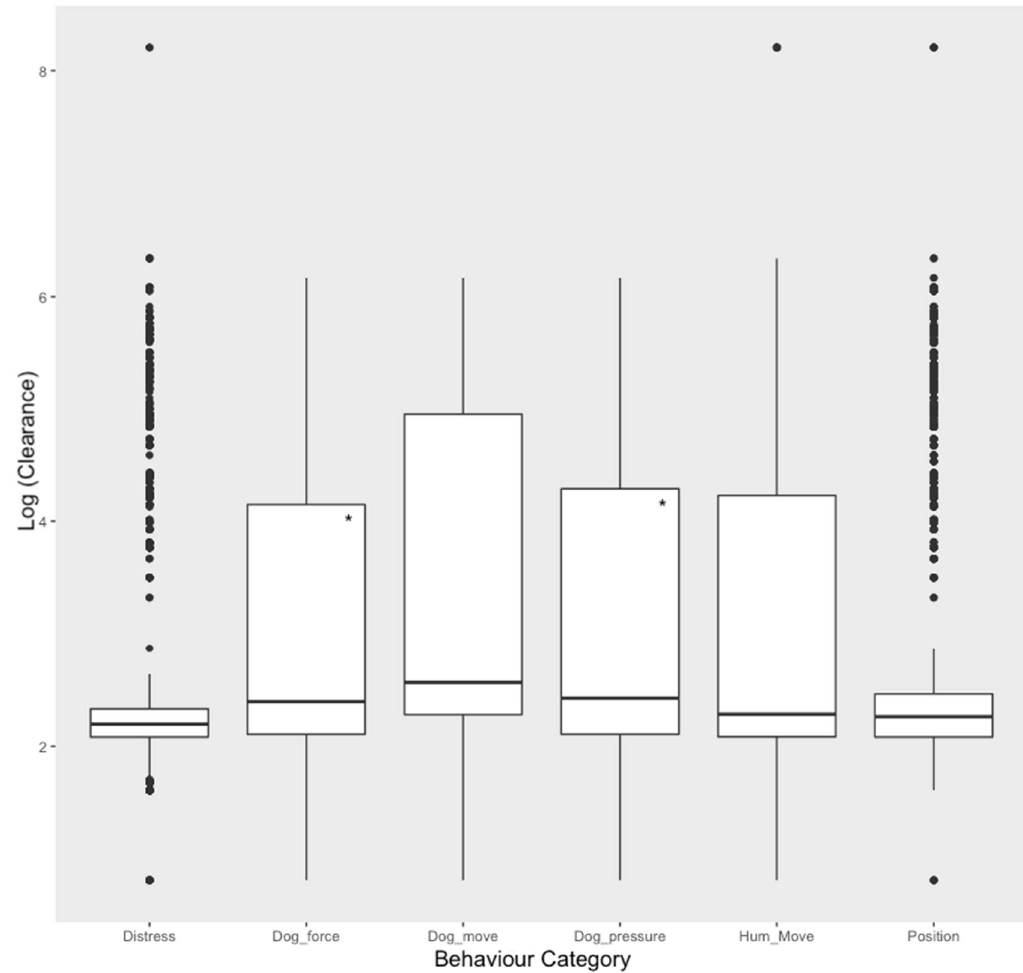
Figure 3. Predicted relationship between behaviour categories and Log (Clearance). Statistically significant results marked with an ‘*’.